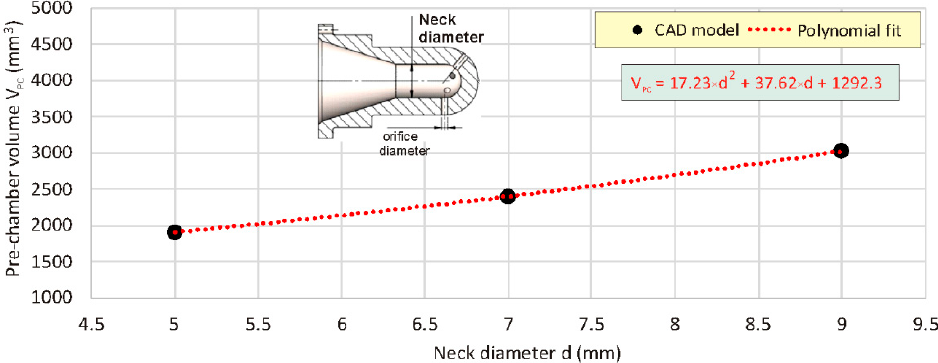
Figure 7. Definition of total pre-chamber volume as a function of neck diameter.